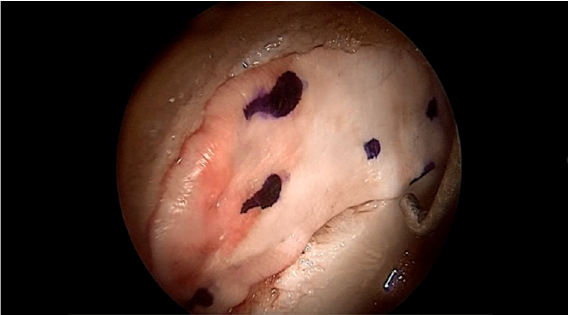
Figure 1. The membrane is applied to cover the acetabular chondral defect, after microfracturing.